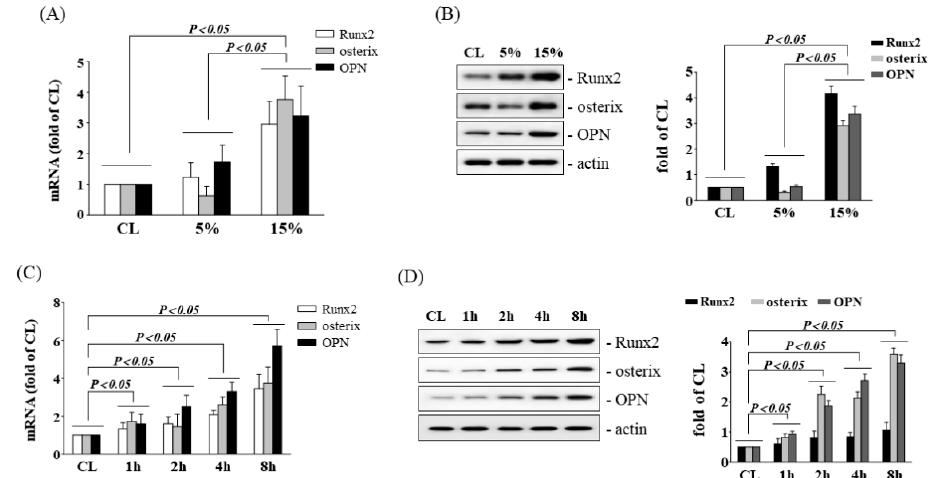
Figure 1. HCS upregulates osteogenic gene expression in human AF cells. ( A , B ) AF cells were kept in static condition as controls (CL) or subjected to LCS (5%) or HCS (15%) for 8 h, and the gene expressions of Runx2, osterix, and OPN ( A ) were determined by real-time PCR analysis. The protein expressions were determined by Western blotting ( B ). ( C , D ) AF cells were subjected to HCS for the indicated times, and the gene expression of Runx2, osterix, and OPN. ( A , C ) were determined by real-time PCR analysis. ( B , D ) The protein expressions were examined by Western blotting. The results are mean ± standard deviation (SD) and are representative of three independent experiments (n = 3). Data statistics were completed with ANOVA followed by Scheffe’s test. Results were considered significant for p < 0.05.